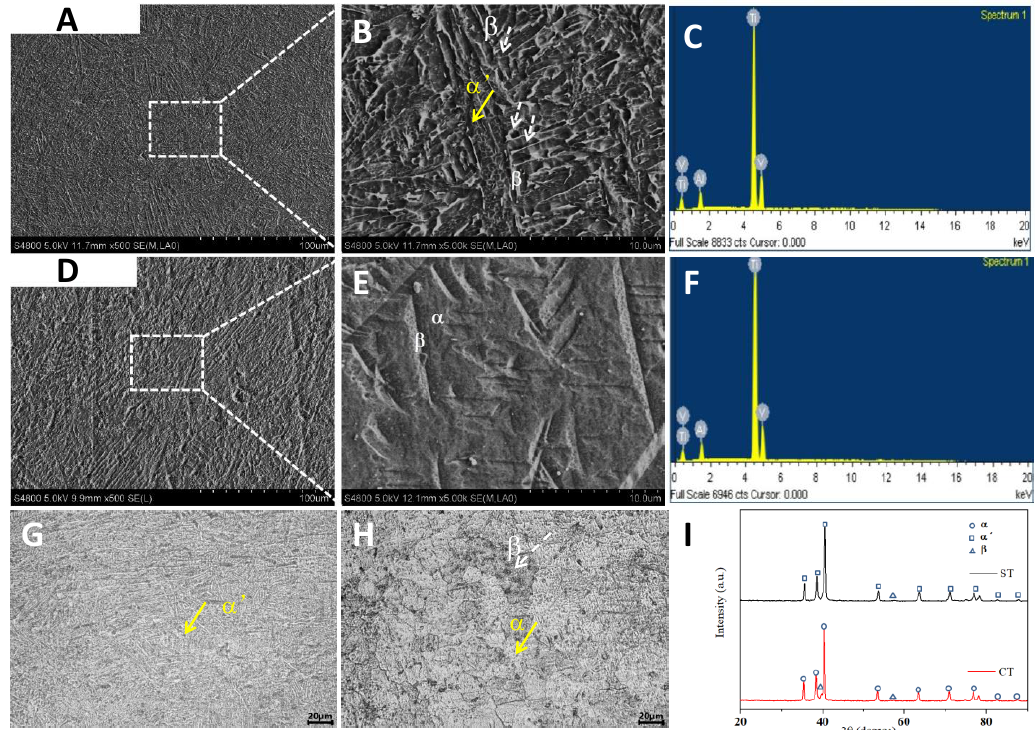
Figure 2. SEM images of ( A , B ) ST and ( D , E ) CT; EDS spectrum of ( C ) ST and ( F ) CT; optical images of ( G ) ST, ( H ) CT; ( I ) XRD patterns for the two samples.